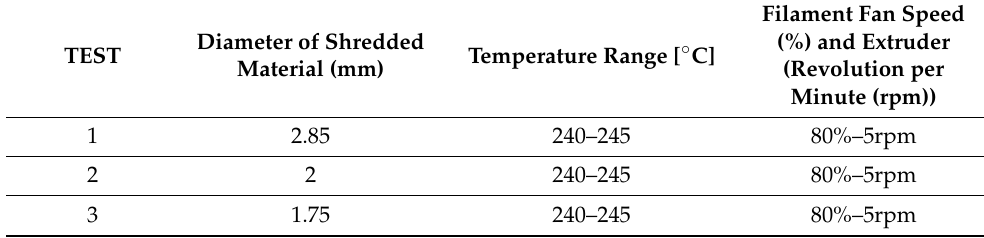
Table 3. Setting and parameters used during the preparation.